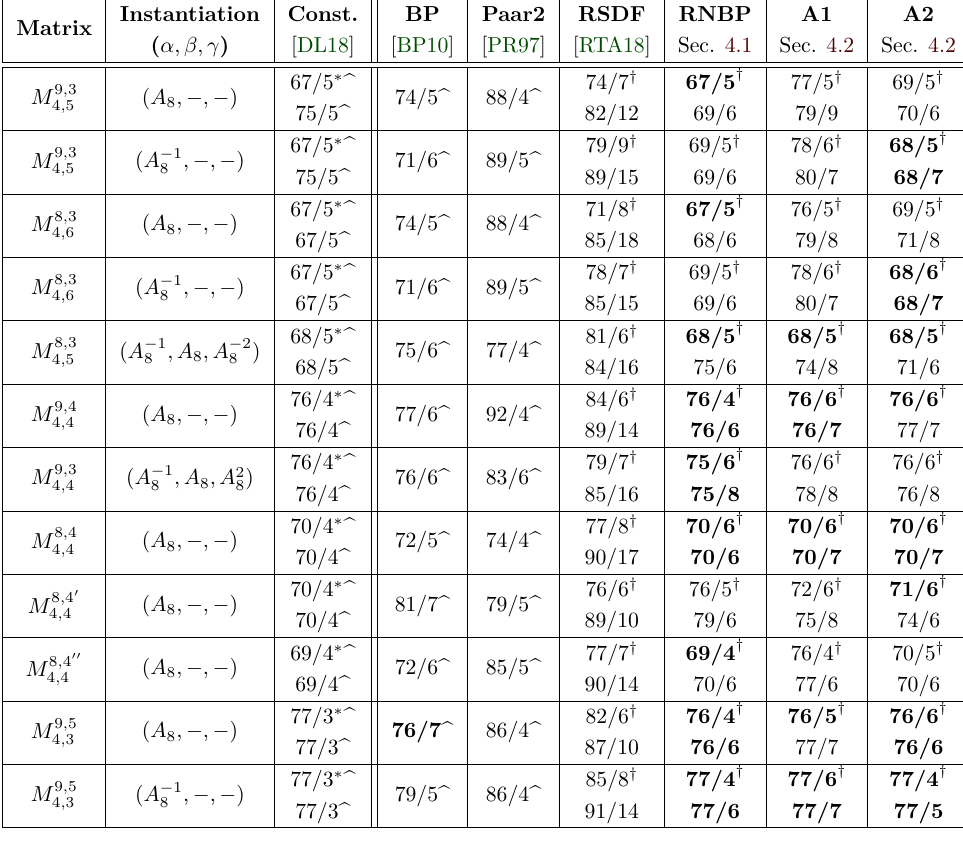
Table 7: Circuit cost (XOR/Depth) of matrices of size 32 × 32 from [DL18] using several optimisation tools